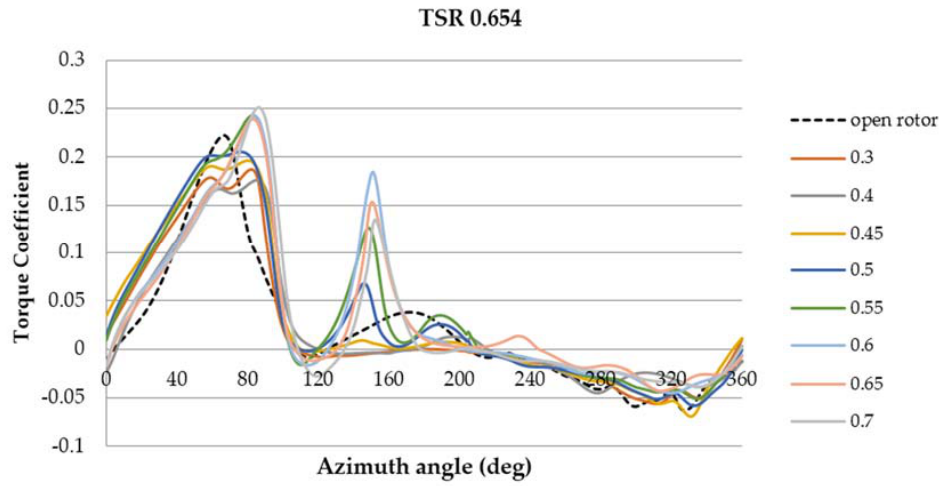
Figure 27. Torque coefficient versus azimuth angle in different shape ratios of the ODGV including the open rotor case.